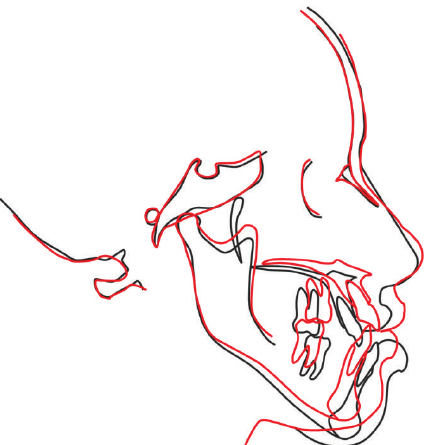
Figure 22: Cephalometric superimposition: before (black) and after